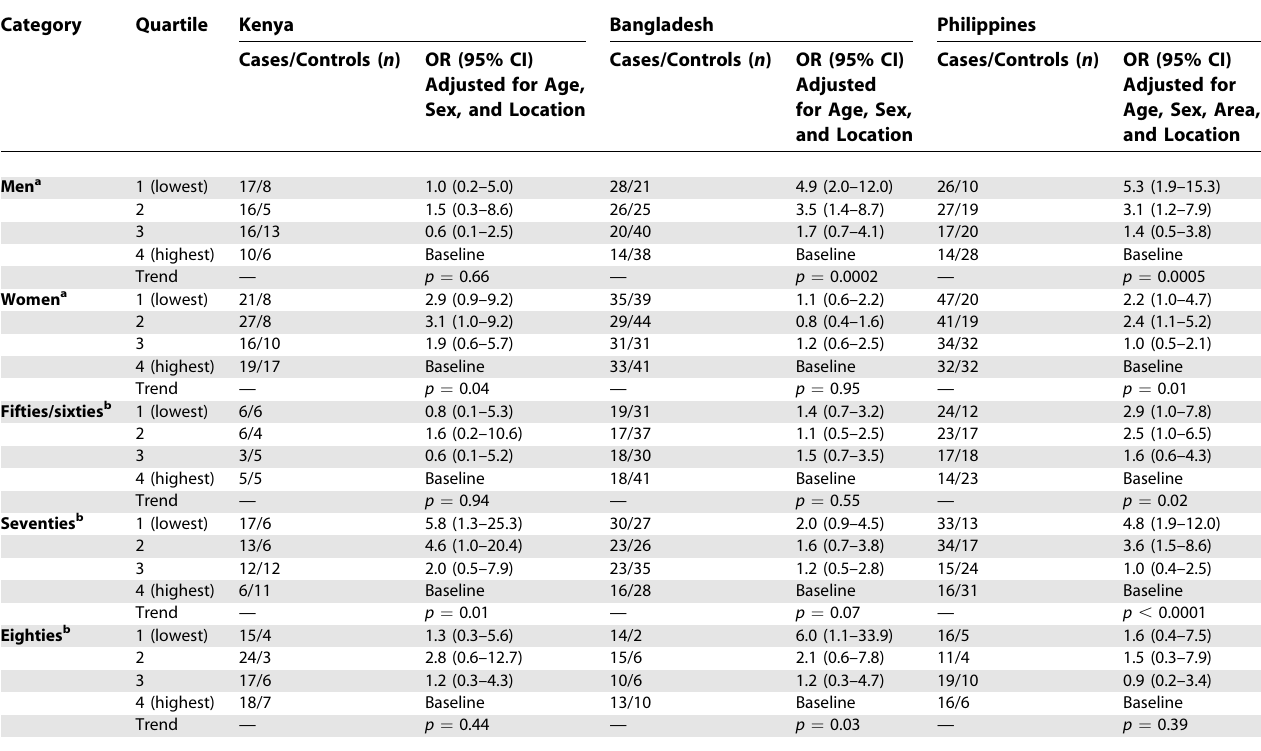
Table 5. Association between Per Capita Expenditure and Cataract in Kenya, Bangladesh, and the Philippines, Stratified by Age and Sex Category Quartile